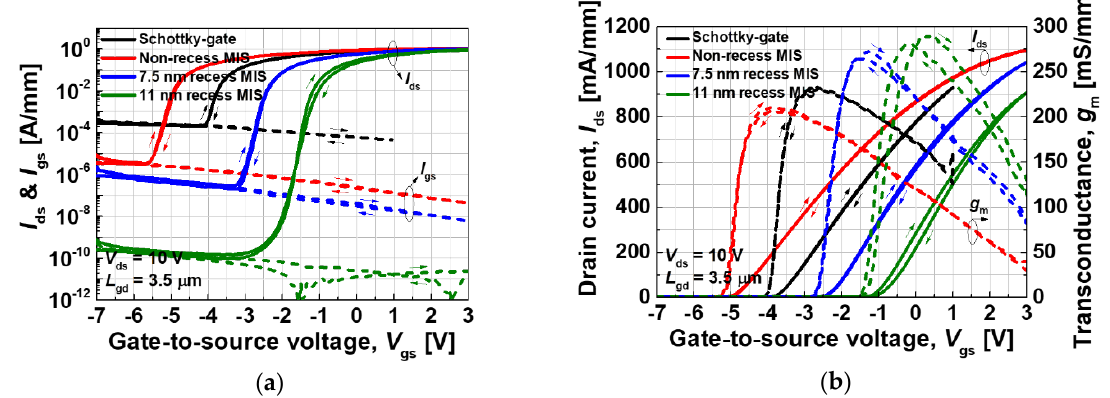
Figure 2. Comparison of the transfer characteristics; ( a ) drain and gate current characteristics in a logarithmic scale and ( b ) transconductance characteristics.